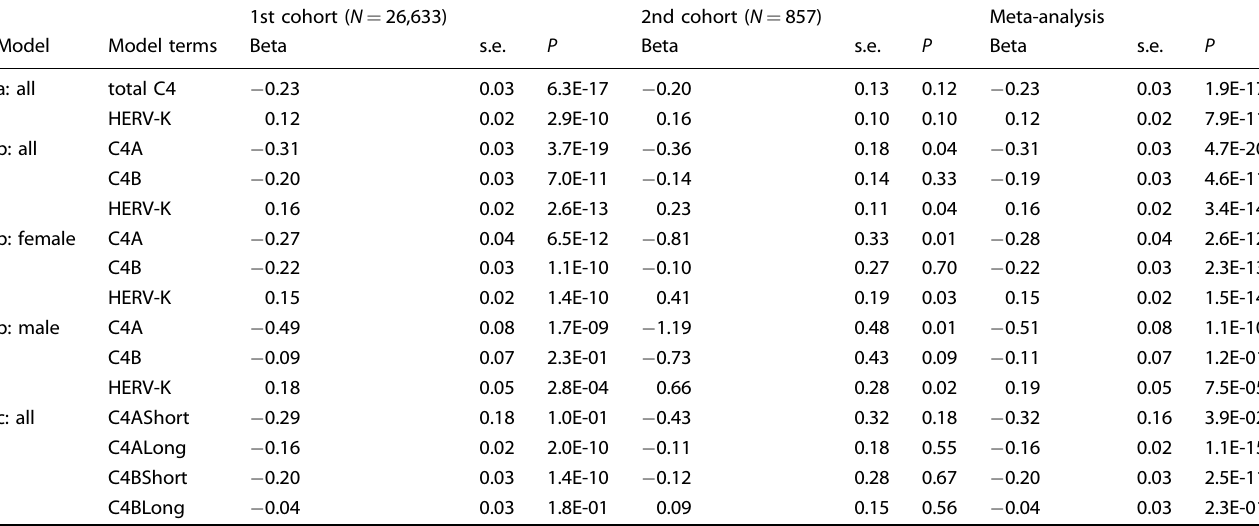
Table 1. Logistic-regression analysis for total C4, C4A, C4B, and HERV-K copy numbers. 1st cohort ( N = 26,633) 2nd cohort ( N = 857)